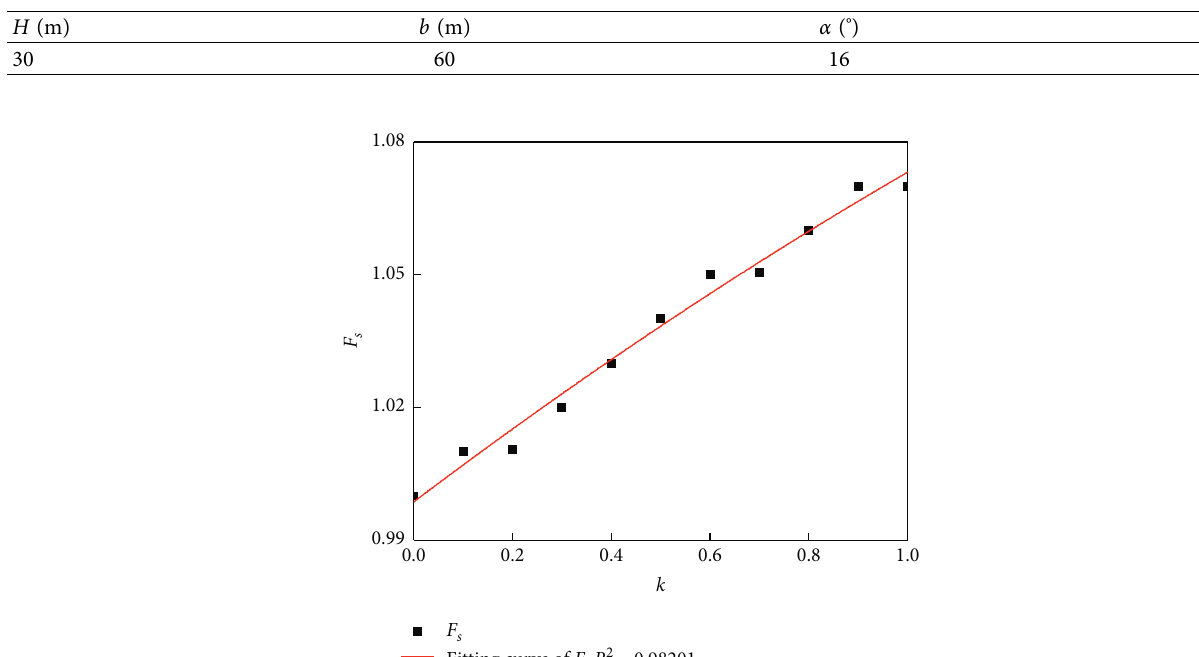
Table 2: Parameters of dump.